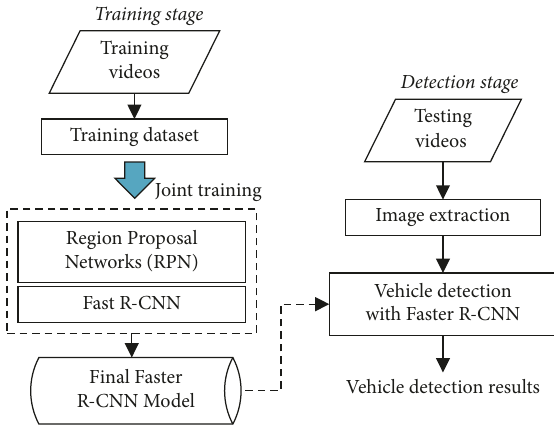
Figure 1: Car detection framework with the Faster